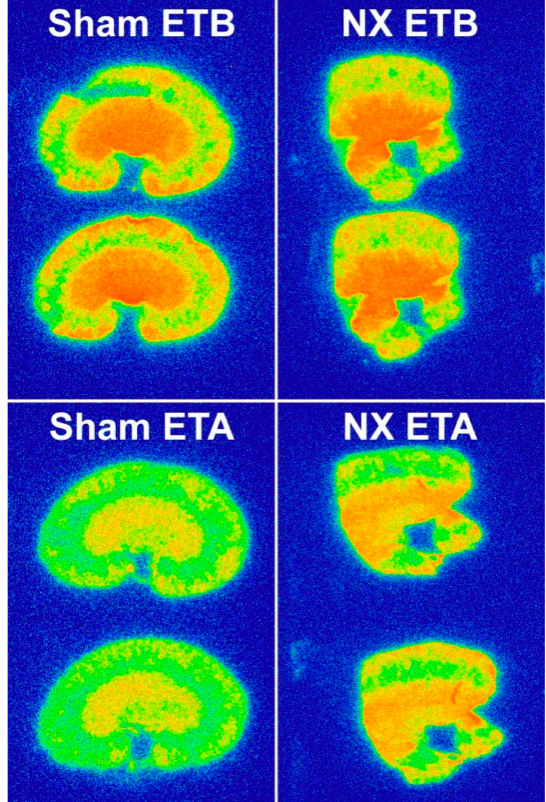
Figure 2. Representative original tracings of kidney ETB and ETA receptor autoradiography in the sham-operated and 5 / 6 nephrectomized rats in the twelve-week 5 / 6 nephrectomy model. 2.2. Twenty-Seven Weeks of Chronic Renal Insu ffi ciency Induced by 5 / 6